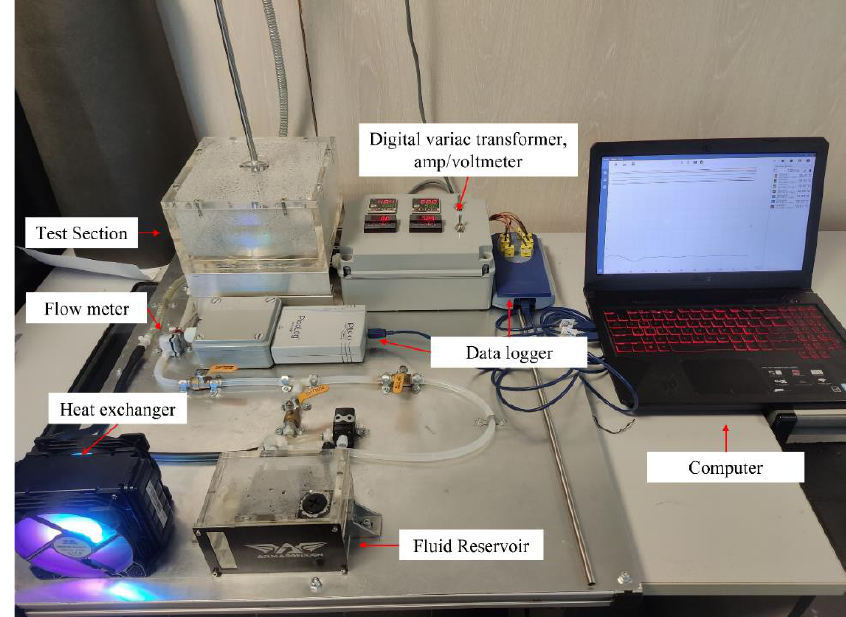
Figure 5. Schematic diagram of the experiment setup.